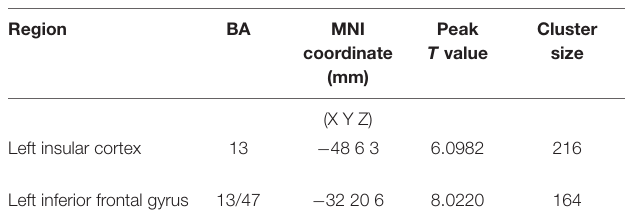
TABLE 4 | Strengthened positive resting-state functional connectivity (RSFC) of left DLPFC post- compared with pre-ER intervention in PD